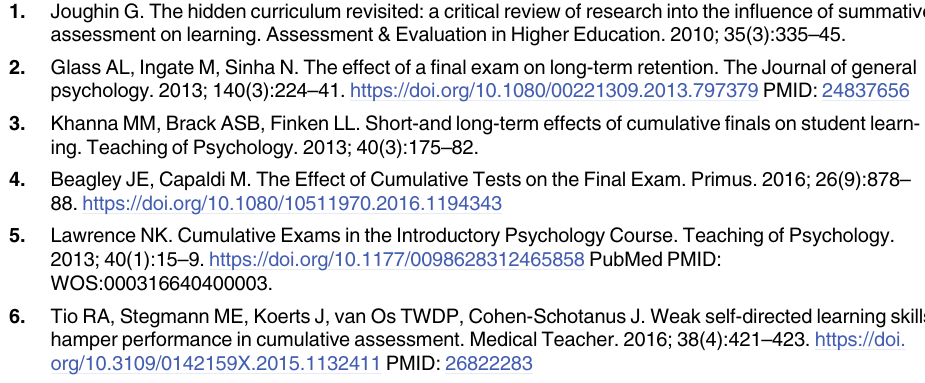
S2 Fig. Student attitudes regarding cumulative and non-cumulative midterms. S3 Fig. Interaction between scientific reasoning and midterm type for long-term retention (LOCS and HOCS